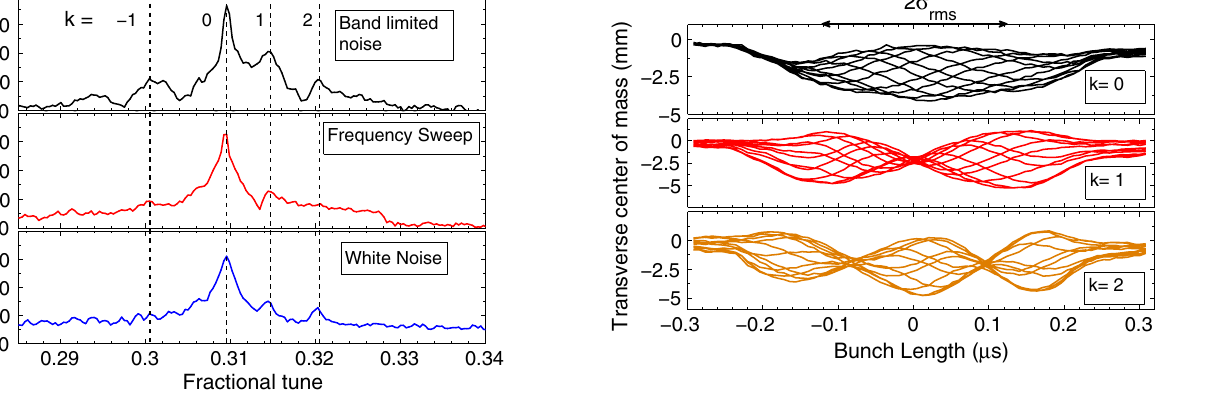
FIG. 18. Horizontal tune spectra over time with U 73 þ at 5 (cid:7) 10 8 particles with band limited noise (rf noise), frequency sweep (chirp noise), and white noise (top to bottom). The dotted lines mark the relative positions of the head-tail modes.